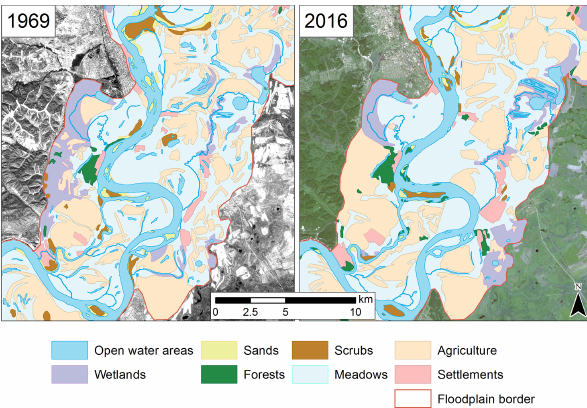
Figure 4. Land cover of the floodplain sections identified for the analysis.